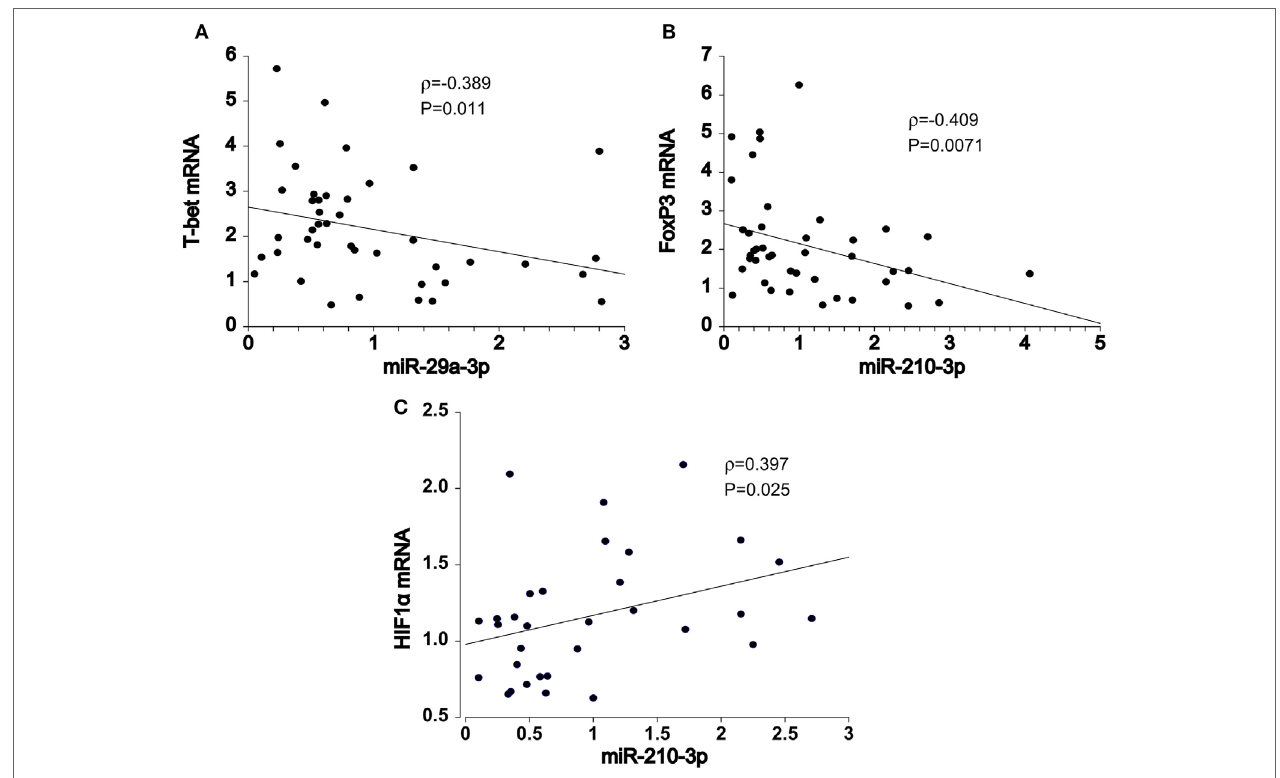
FigUre 2 | Spearman pair-wise correlation analysis of miRNA-mRNA target pairs in pooled samples ( N = 42). Declining (a) miR-29a-3p expression levels was associated with increments in T-bet transcript abundance. Similar, negative relationship was also noted between (B) miR-210-3p and FOXP3 mRNA levels. Conversely, (c) miR-210-3p was positively correlated with HIF1 α gene expression. Spearman rank-test, solid line: the least square estimate. ρ —Spearman correlation coefficient; global significance P <